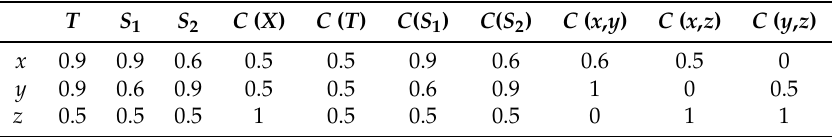
Table 4. The choice function and feasible subsets in Example 4. We omit brackets for simplicity. T S 1 S 2 C ( X ) C ( T ) C ( S 1 ) C ( S 2 ) C ( x , y ) C ( x , z )